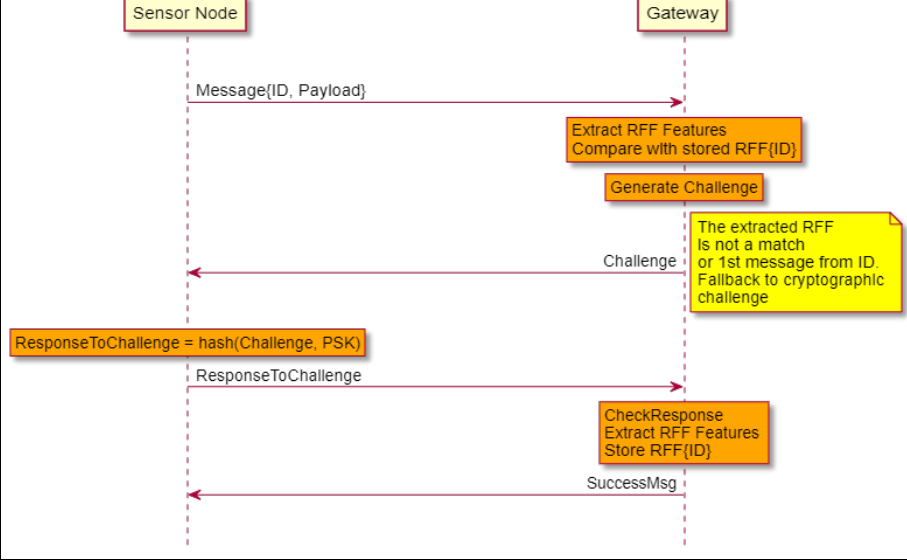
Figure 4. Unsuccessful Authentication by RFF and fallback to